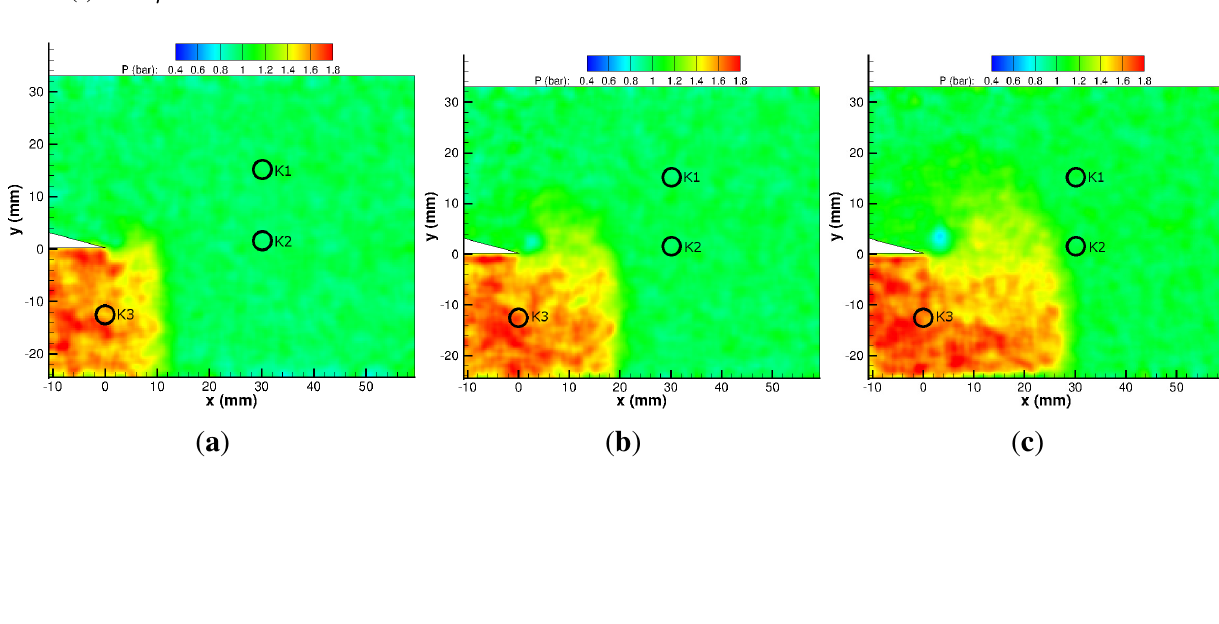
Figure 10. PSP map of M = 1 . 28 shock diffraction process. ( a ) 20 µ s; ( b ) 40 µ s; ( c ) 60 µ s; i ( d ) 80 µ s; ( e ) 100 µ s; ( f ) 120 µ s; ( g ) 140 µ s; ( h ) 160 µ s; ( i ) 180 µ s; ( j ) 200 µ s; ( k ) 220 µ